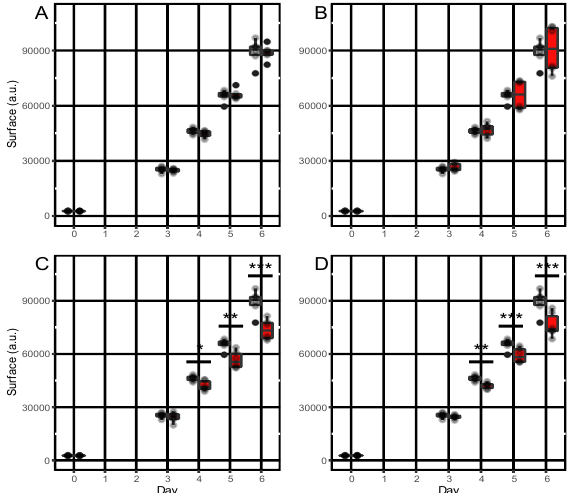
Figure 4. Inhibitory effect of terpenes on Alternaria dauci growth. Growth of Alternaria dauci was monitored as described in Section 2 (Materials and Methods). Two independent experiments with 3 replicates were performed. The surface of Alternaria mycelium was measured at days 0, 3 and 6. Controls are in gray and terpene assays in red. Tested terpenes were: ( A ) camphene, ( B ) α - pinene, ( C ) caryophyllene, ( D ) α -humulene. The symbols *, ** and *** indicate significantly different mycelium surfaces compared to control conditions using a T test, with p -value <0.05, <0.01 and <0.001,